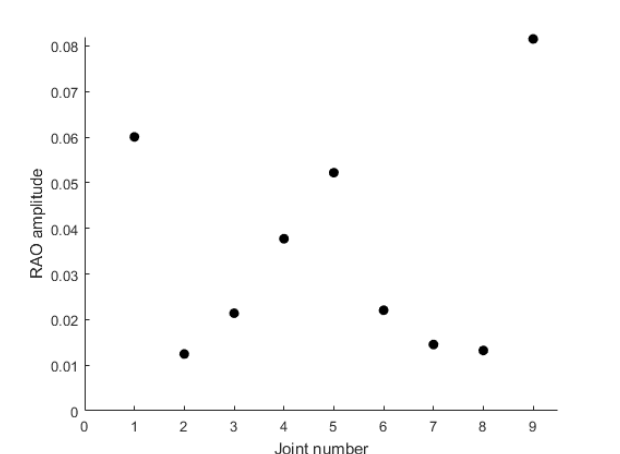
Fig. 16. Amplitudes of the motion of each of the nine joints in roll, relative to the incoming wave motion. Wave period: 8.5s, wave angle: